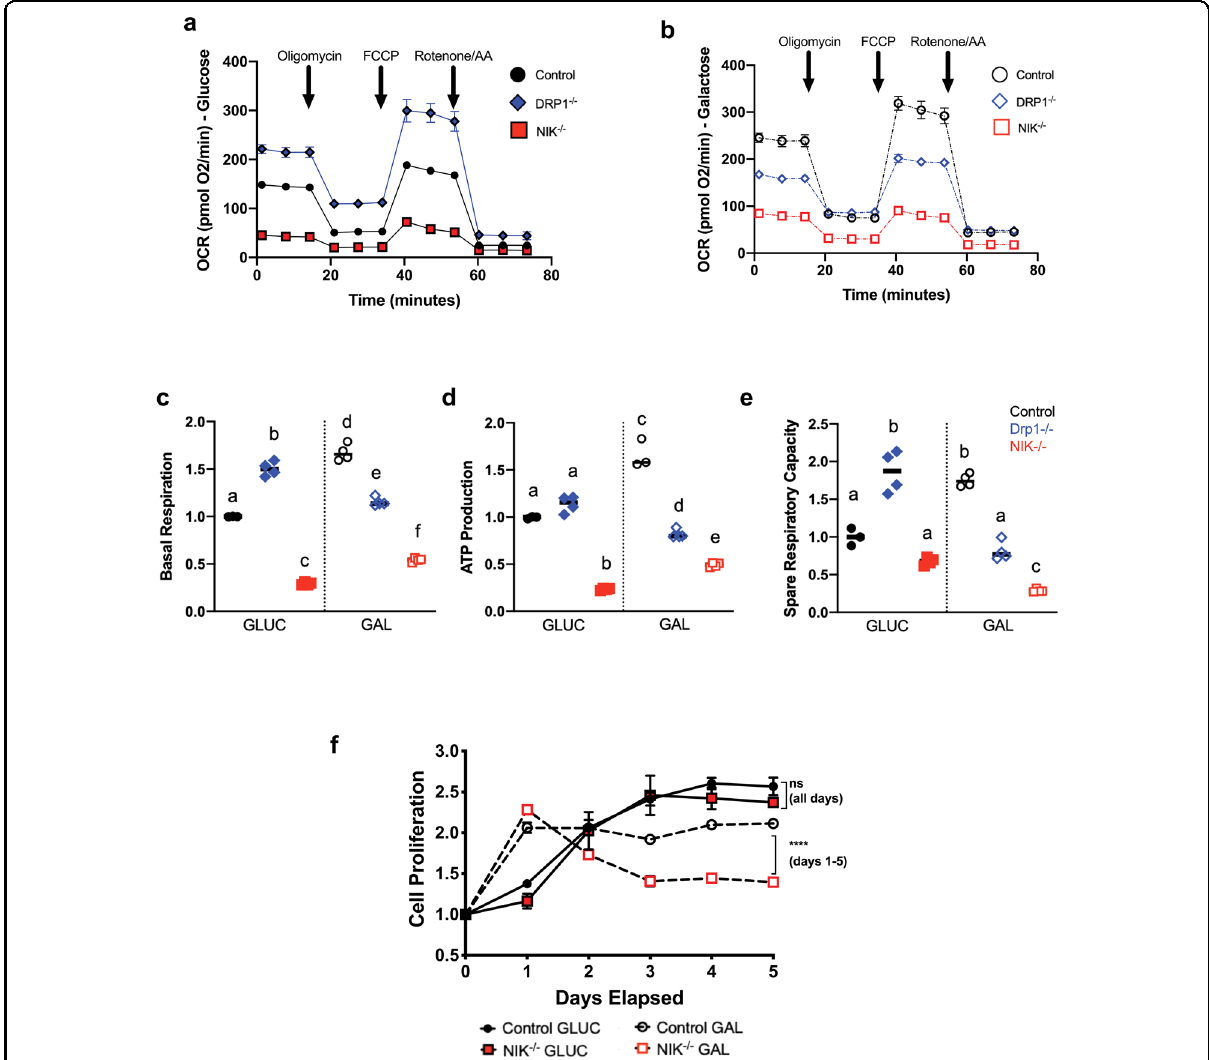
Fig. 4 NIK promotes cell survival by increasing mitochondrial spare respiratory capacity in response to forced reliance on OXPHOS. a , b Oxygen consumption rate (OCR) was measured using the Seahorse Mito Stress test with control cells (see Fig. 2b), DRP1 − / − and NIK − / − cells that were cultured in a 18 mM glucose (GLUC), or b 18 mM galactose (GAL) media. Data shown are the mean ± SD of ≥ 3 replicates for each cell type in each condition and are representative of at least three independent experiments. OCR values were normalized to cellular DNA content (DRAQ5 relative fl uorescence units (RFUs)). c – e Individual mitochondrial function parameters were calculated from the data shown in a and b and shown as fold change compared to control cells in GLUC. Data for control cells was taken from Fig. 2b. c Basal respiration. Different letters indicate statistical signi fi cance using one-way ANOVA with Tukey post-hoc test. All comparisons have p < 0.0001 except “ a vs e ” ( p < 0.05) and “ b vs d ” ( p < 0.01). d ATP production. All statistical comparisons have p < 0.0001 except “ a vs d ” ( p < 0.05), “ c vs f ” ( p < 0.001). e Spare respiratory capacity. All statistical comparisons have p < 0.0001 except “ a vs c ” ( p < 0.05). f Representative MTS Proliferation assay. Control and NIK − / − cells were cultured in GLUC or GAL for the indicated times. Proliferation is represented as fold change compared to day 0. Data are representative of three different experiments and are shown as mean ± SD ( n = 3) with two-way ANOVA followed by Tukey post-hoc test (**** p <